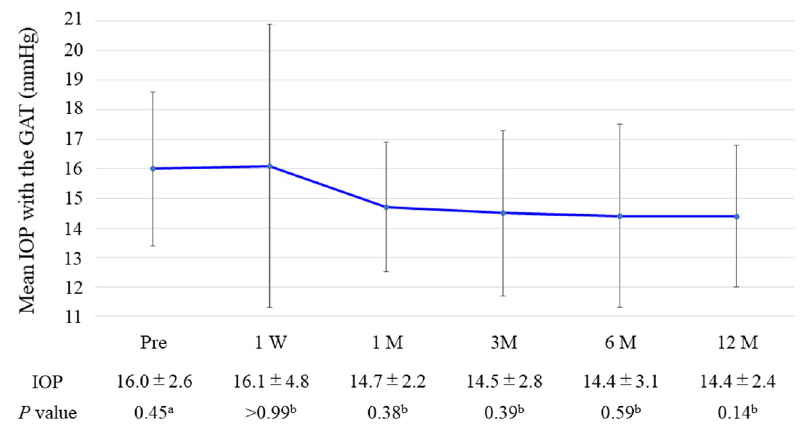
Figure 1. Changes in mean IOP were measured with GAT throughout follow-up. The error bar shows the standard deviation. GAT, Goldmann applanation tonometer; IOP, intraocular pressure; W, week; M, month. P -values: a one-way repeated measures ANOVA; b paired t -test versus baseline with Bonferroni correction.